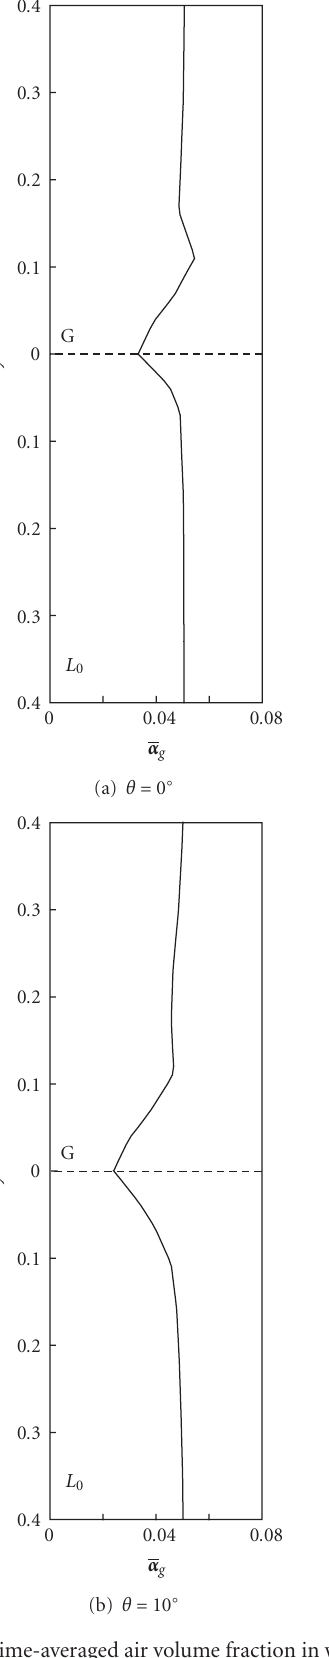
Figure 9: Time-averaged air volume fraction in wake.